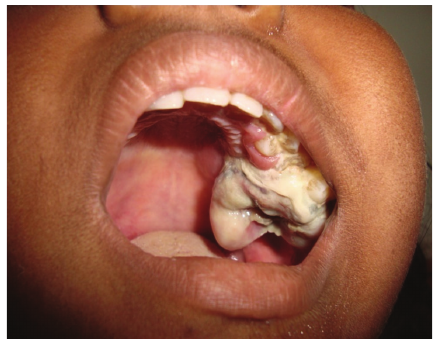
Figure 2: Intraoral growth on left side of maxilla.